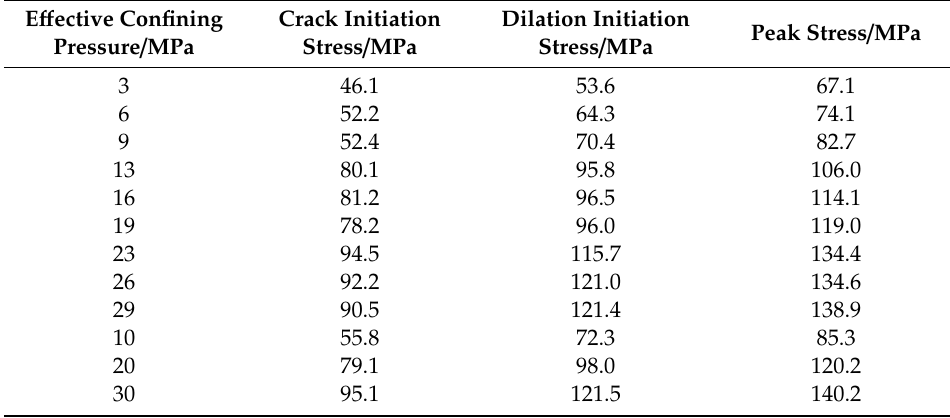
Table 2. The characteristic stress on sandstone under di ff erent e ff ective confining pressures. E ff ective